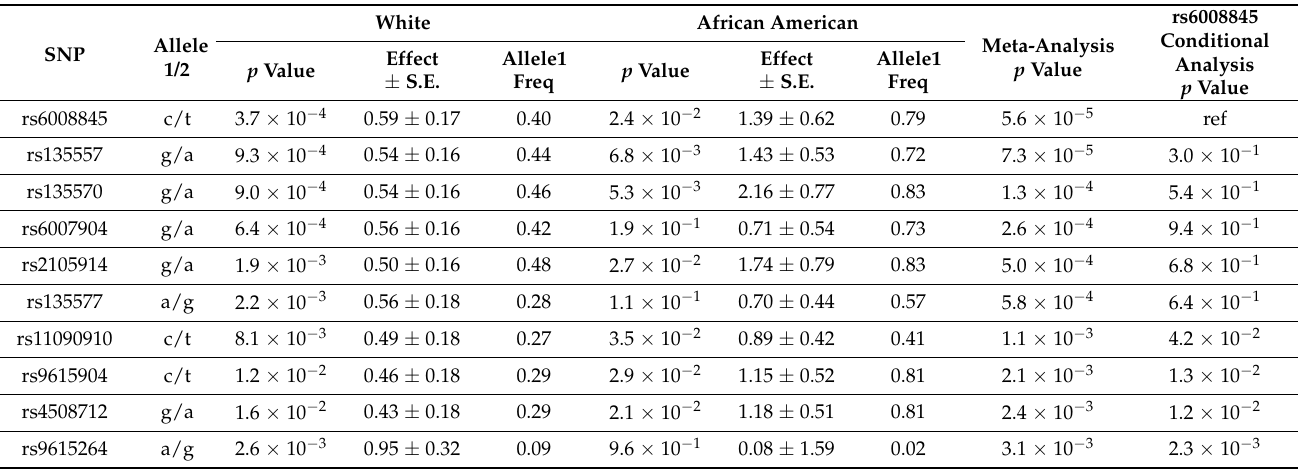
Table 1. Characteristics of the top SNPs at the PPARA locus modulating fenofibrate effectiveness in ACCORD among self-reported non-Hispanic Whites and African Americans and in a meta-analysis of the two